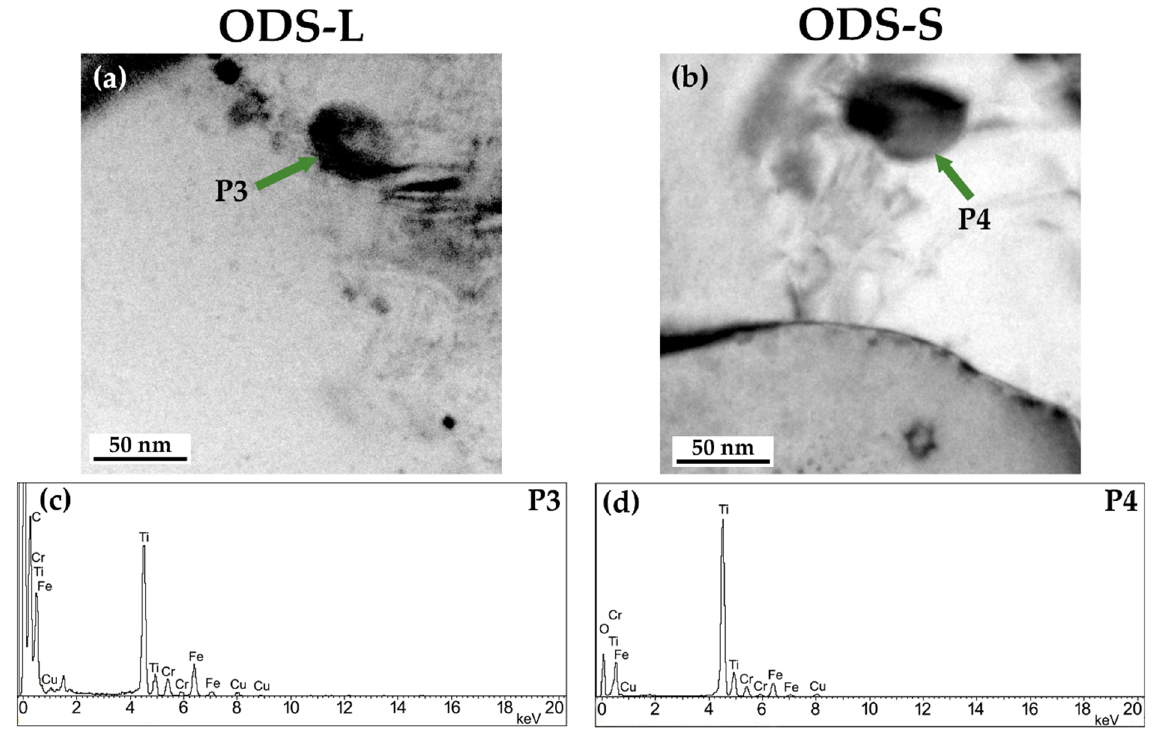
Figure 11. BF-TEM micrographs and corresponding XEDS spectra showing Ti-rich precipitates (marked with arrows) on ODS-L ( a , c ) and ODS-S ( b , d ) steels annealed at 1273 K after HCR.